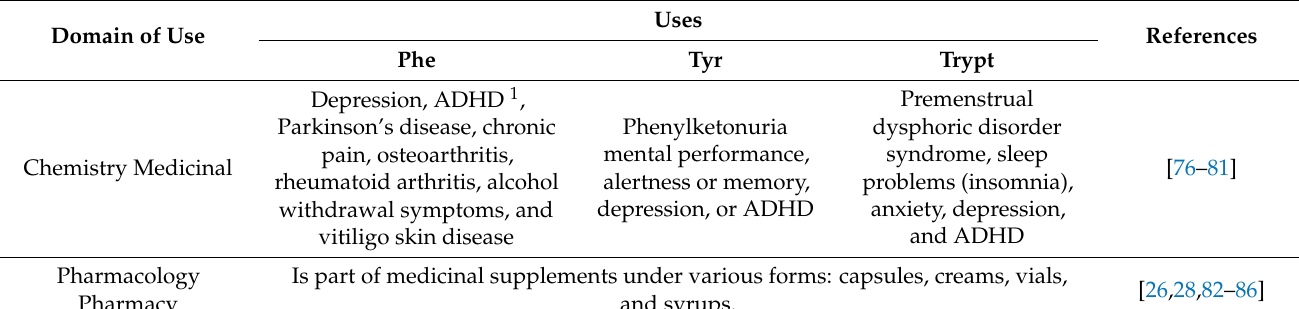
Table 3. The uses of AAs: Phe, Tyr,